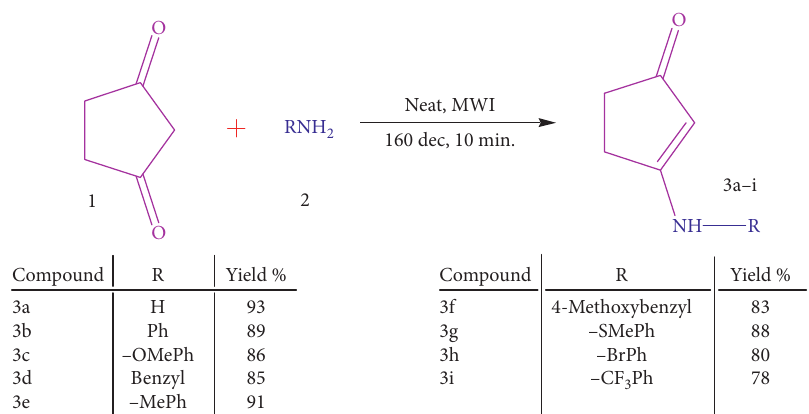
Scheme 2: Synthesis of compounds 3a-i under microwave irradiation.